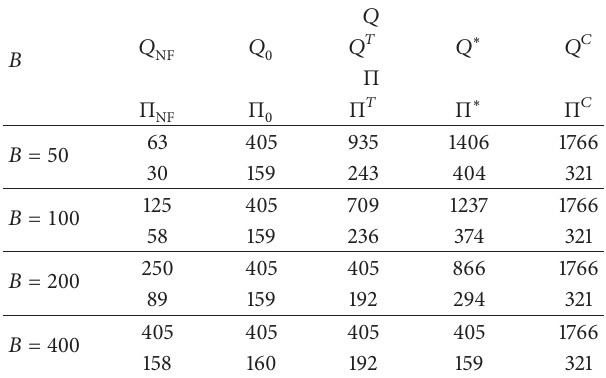
Figure 2: Relation between the optimal ordering quantities with different financial modes. Table 1: Optimal ordering quantity of the distributor and the total profit of supply chain